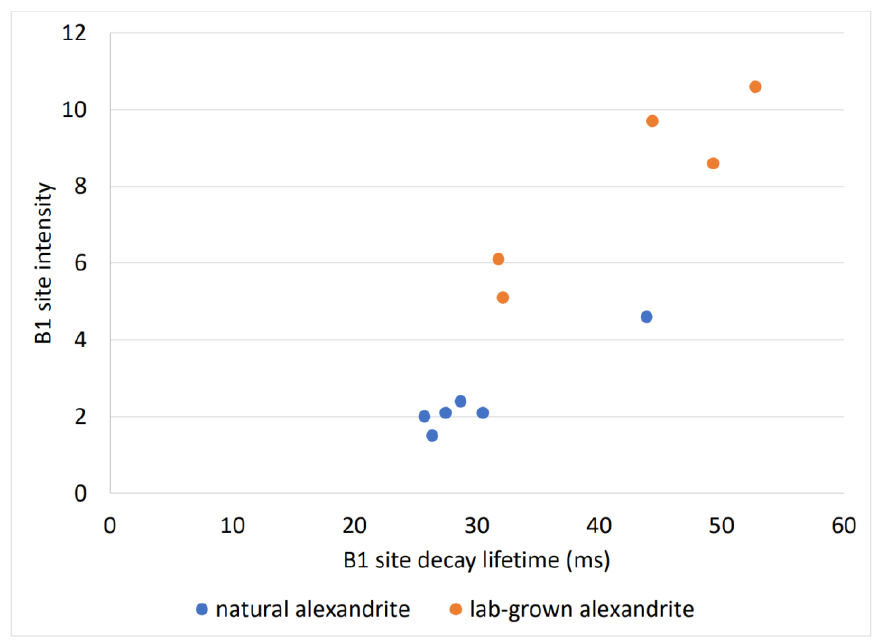
Figure 10. Plotting the B1 site decay lifetime with the B1 site starting intensity. This resulted in a better separation between the natural and lab-grown alexandrite.